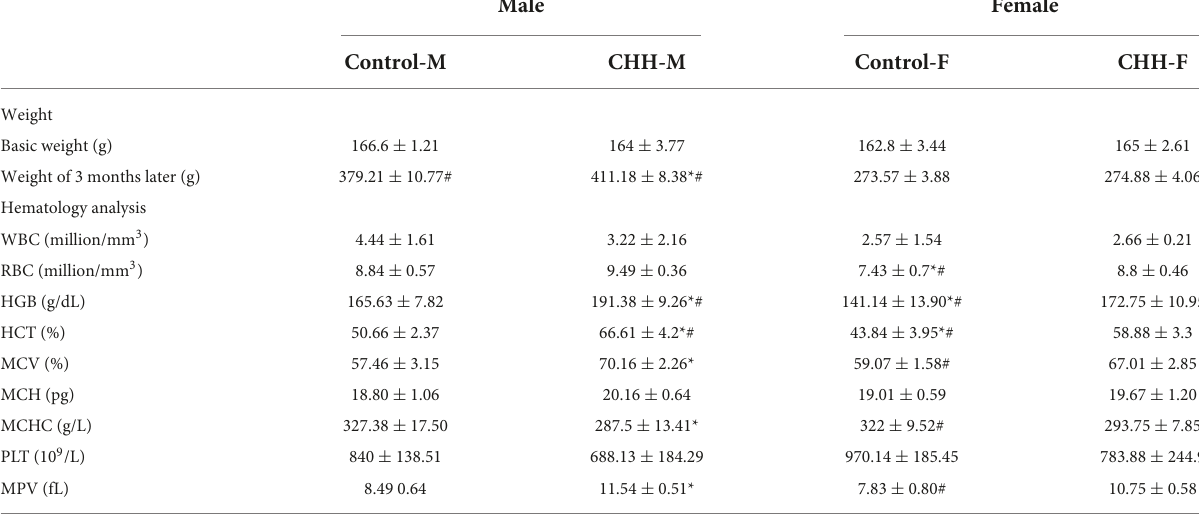
TABLE 2 Parameters of hematology in male and female rats with or without CHH exposure.